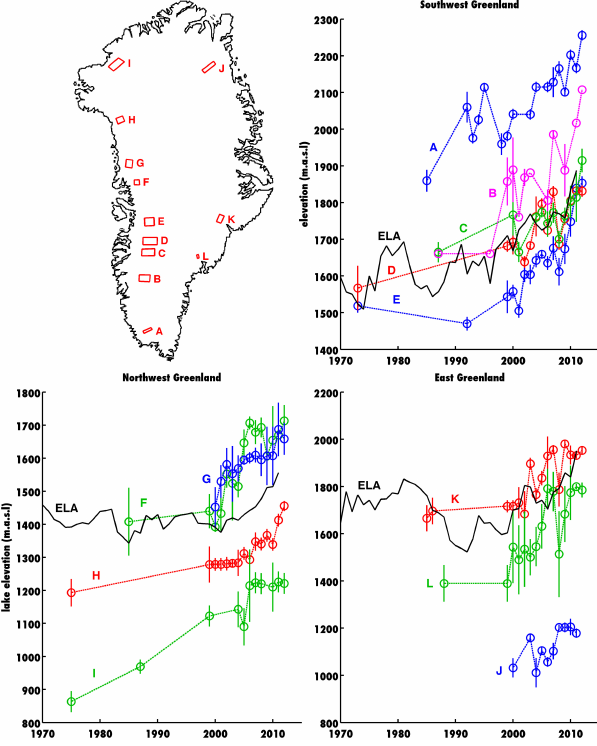
Fig. 2. Elevation of upper 0.1km 2 of lake area within each study area labeled A–L. Error bars result from the ± 0.05 uncertainty in normalized radiance threshold for lake classification. Black curves are the average equilibrium line altitudes (ELA) for those regions smoothed with a 5-yr retrospective mean. ELA values are ex- tracted from the Regional Atmospheric Climate Model version 2 (RACMO2) (van Angelen et al.,